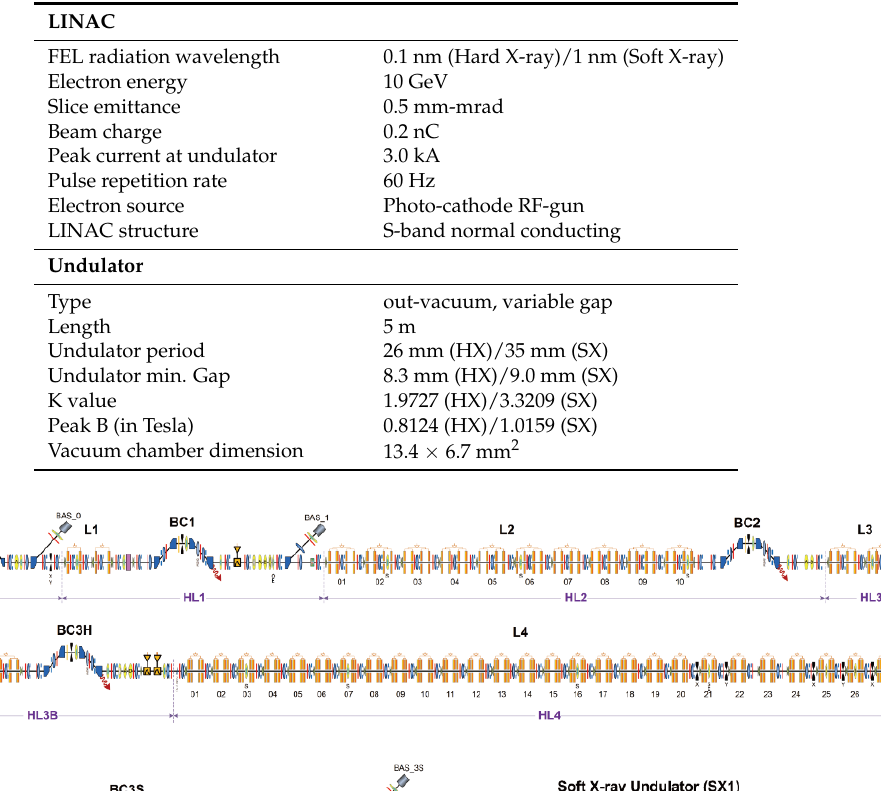
Table 2. Major parameters of PAL-XFEL.